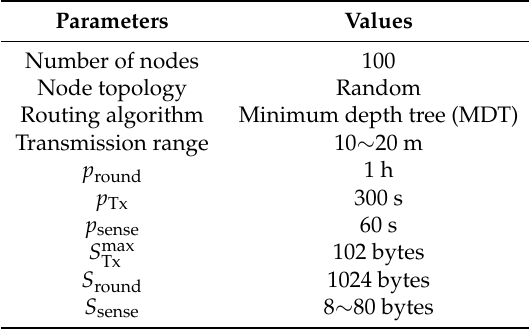
Table 2. Simulation